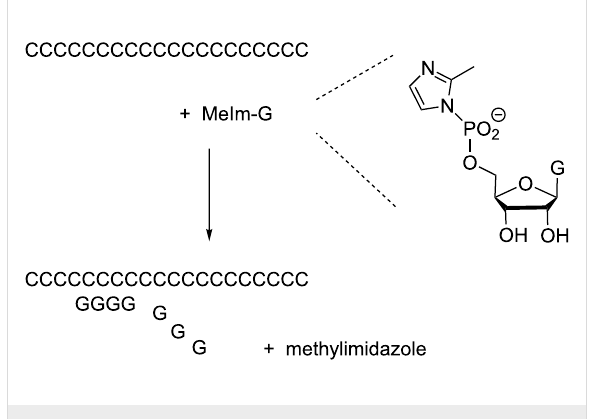
Figure 2: Oligomerization of the 2-methylimidazolide of guanosine-5'- monophosphate on a poly(C)